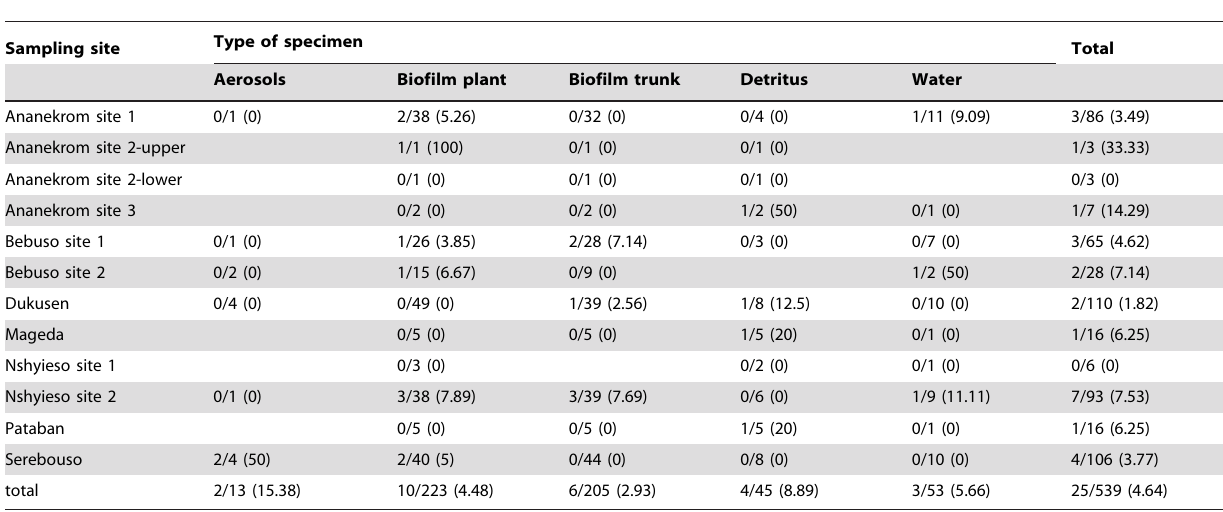
Table 3. Detection of IS 2404 target in FLA cultures per type of specimen and sampling site.